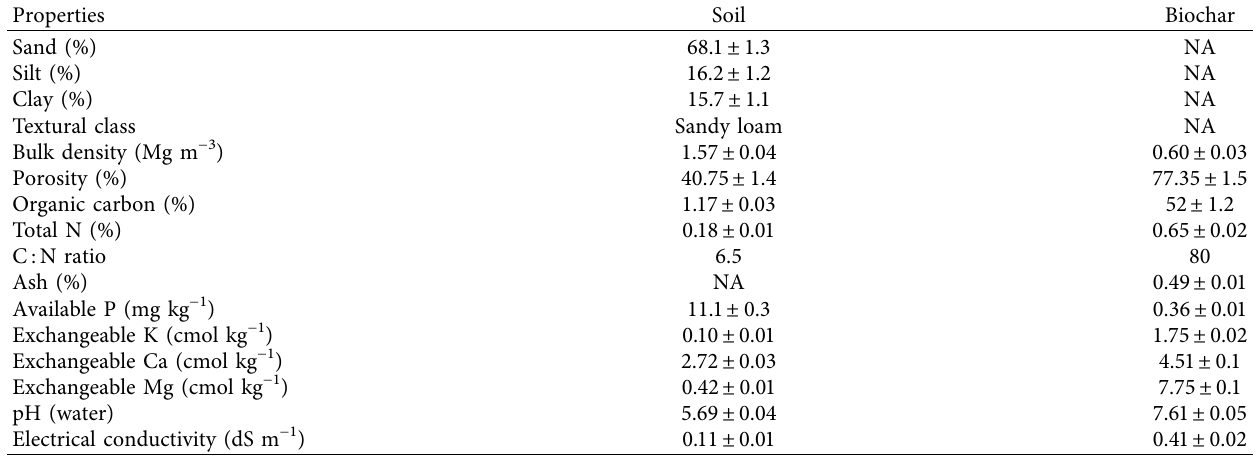
Table 1: Properties of the experimental site and biochar prior to experimentation in